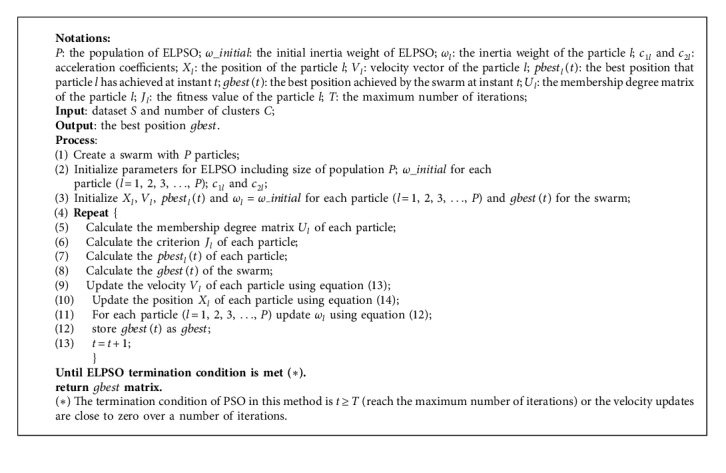
 ELPSO clustering.